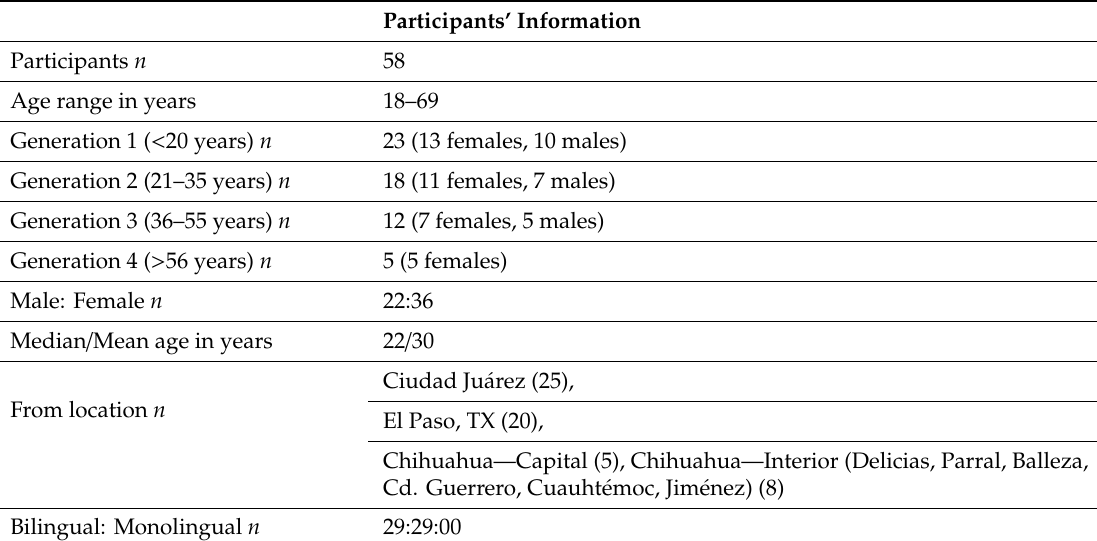
Table 1. Participants’ demographic